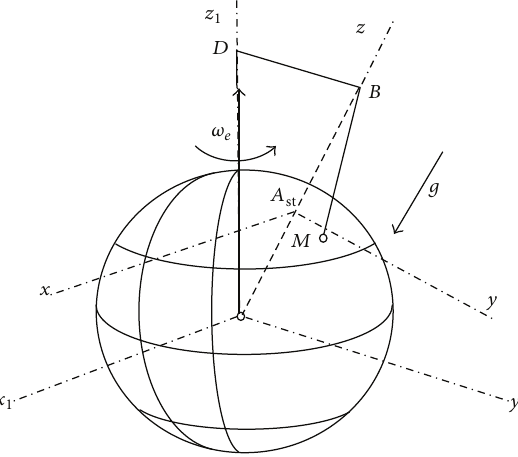
Figure 7: Foucault’s pendulum schematic